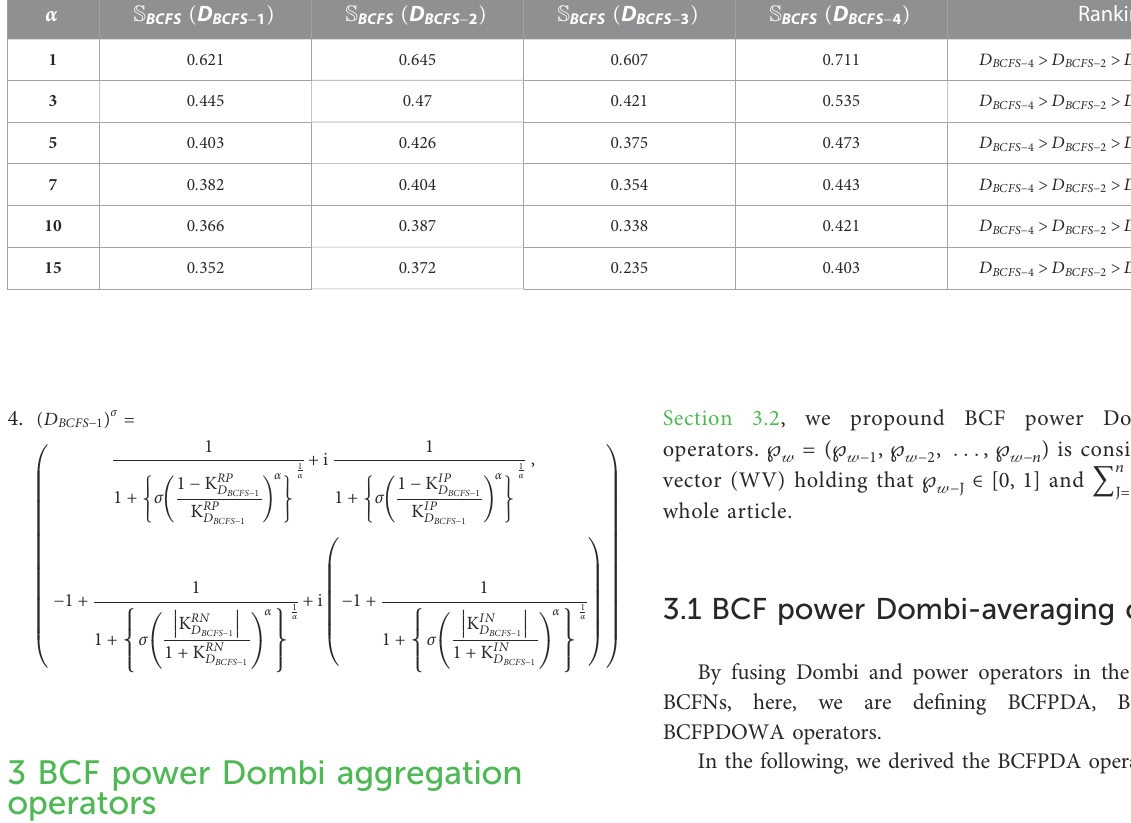
TABLE 11 Score values and ranking order for various values of α using the BCFPDWA operator.